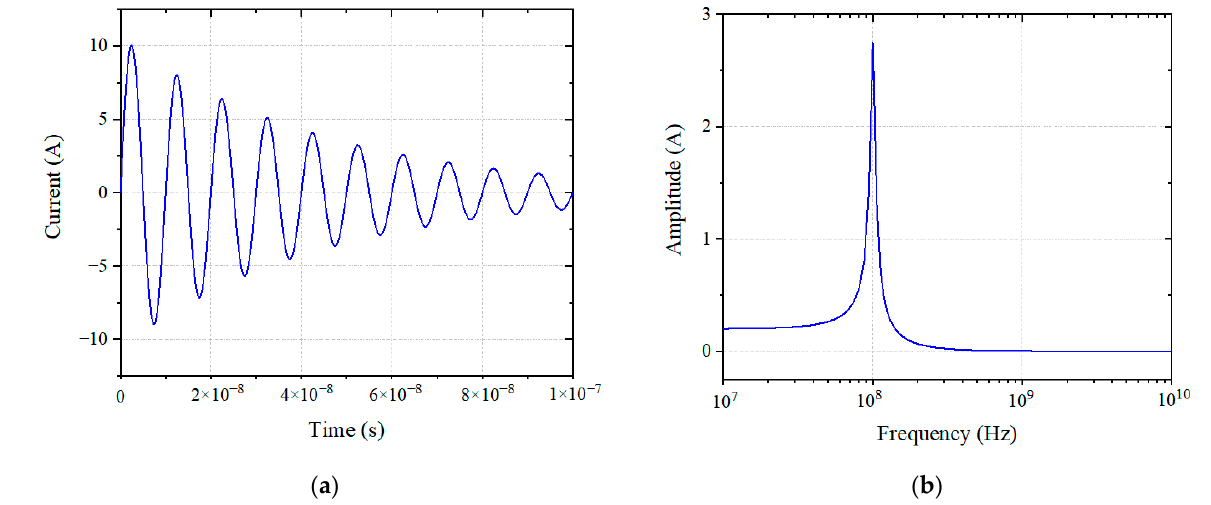
Figure 5. Pulse current injection signal: ( a ) time domain signal; ( b ) frequency domain signal.